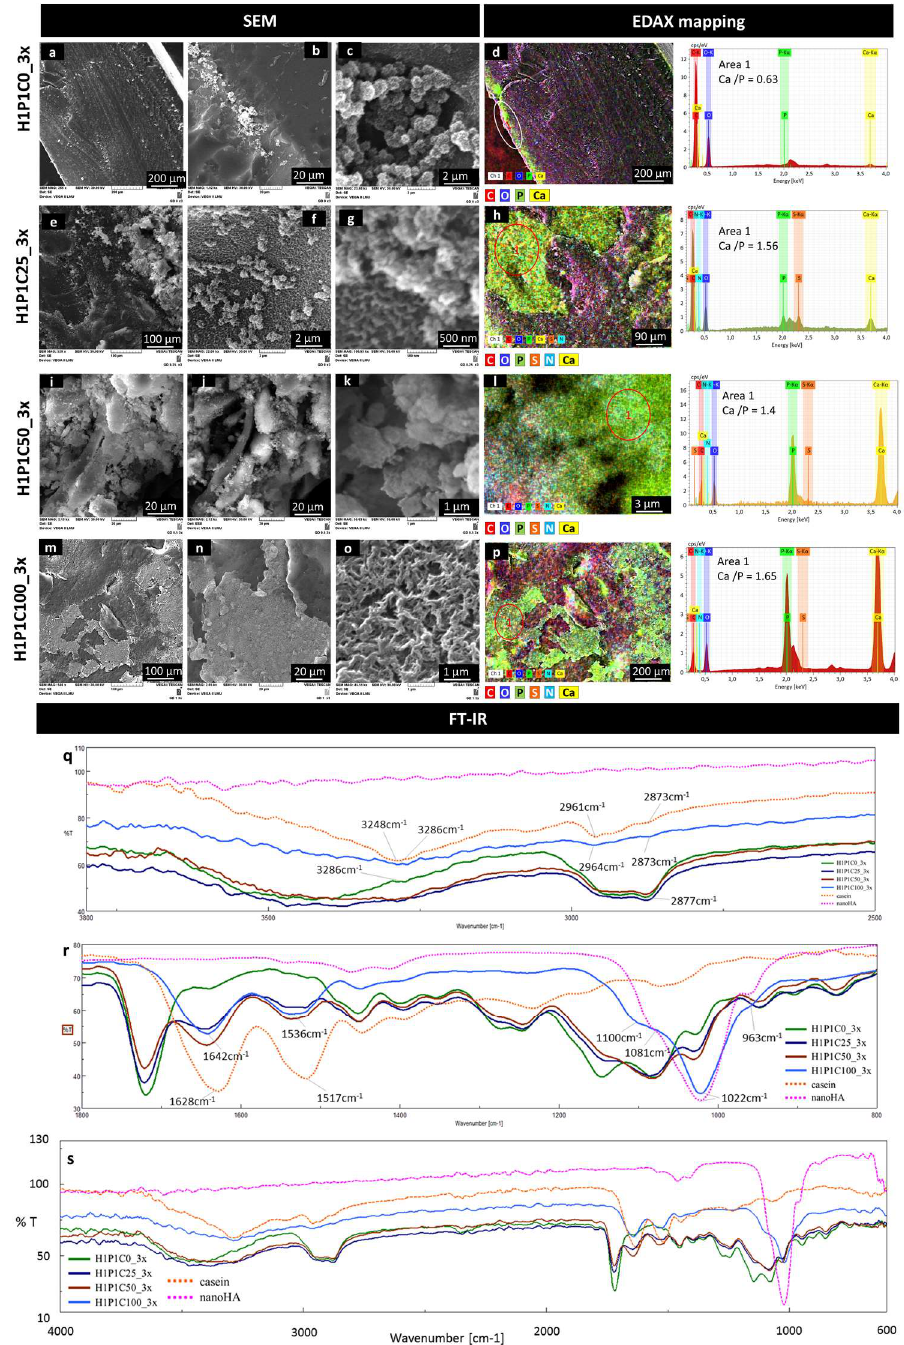
Figure 7. Representative SEM micrographs ( a – c , e – g , i – k , m – o ) and EDAX mapping ( d , h , l , p ) exploring microstructural changes after 3 cycles of mineralisation: H1P1C25, H1P1C50, H1P1C100 hybrids with increasing casein content, and representative EDAX spectra of the mineralised areas 1. H1P1C0 hydrogel was used as a control; representative FT-IR spectra recorded onto the surface: wavenumber interval 3000-2500 cm −1 ( q ), wavenumber interval 1800-800 cm −1 ( r ), whole range 4000- 600 cm −1 ( s ).